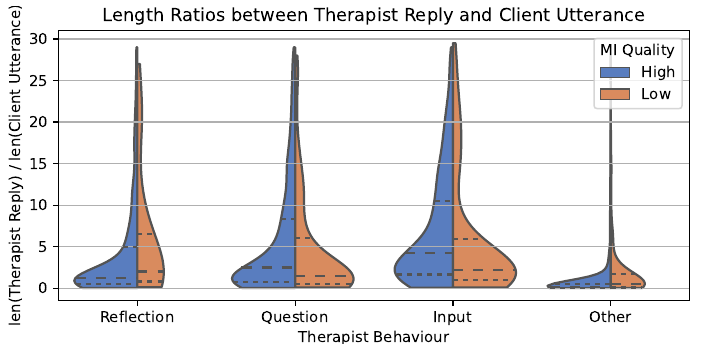
Figure 9. Ratios between the length (number of words) of the next-turn therapist response (broken down into 4 types of therapist behaviours) and that of the current-turn client